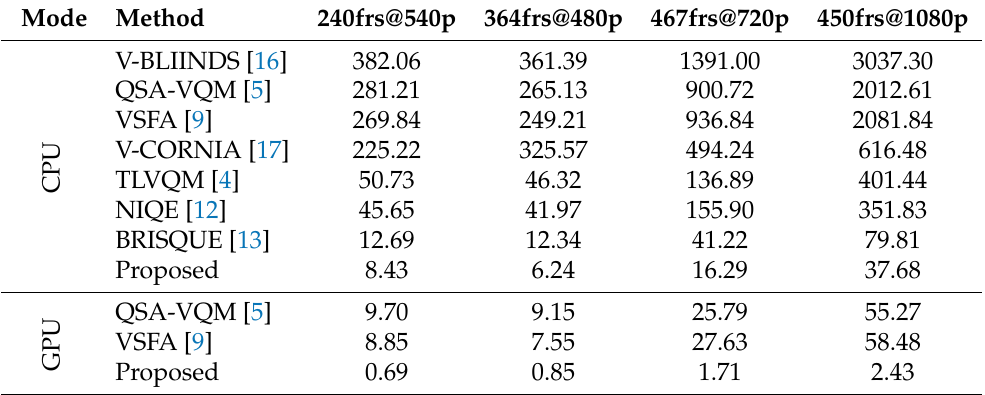
Table 4. Computation time comparison in seconds for four videos selected from the considered